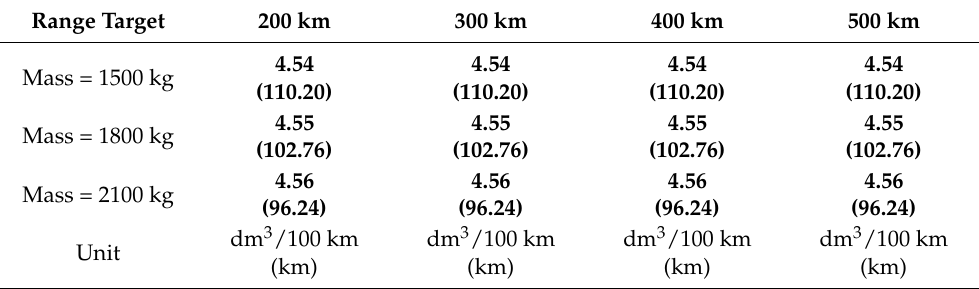
Table A15. Fuel consumption in EREV mode for constant speed drive at 140 km/h.